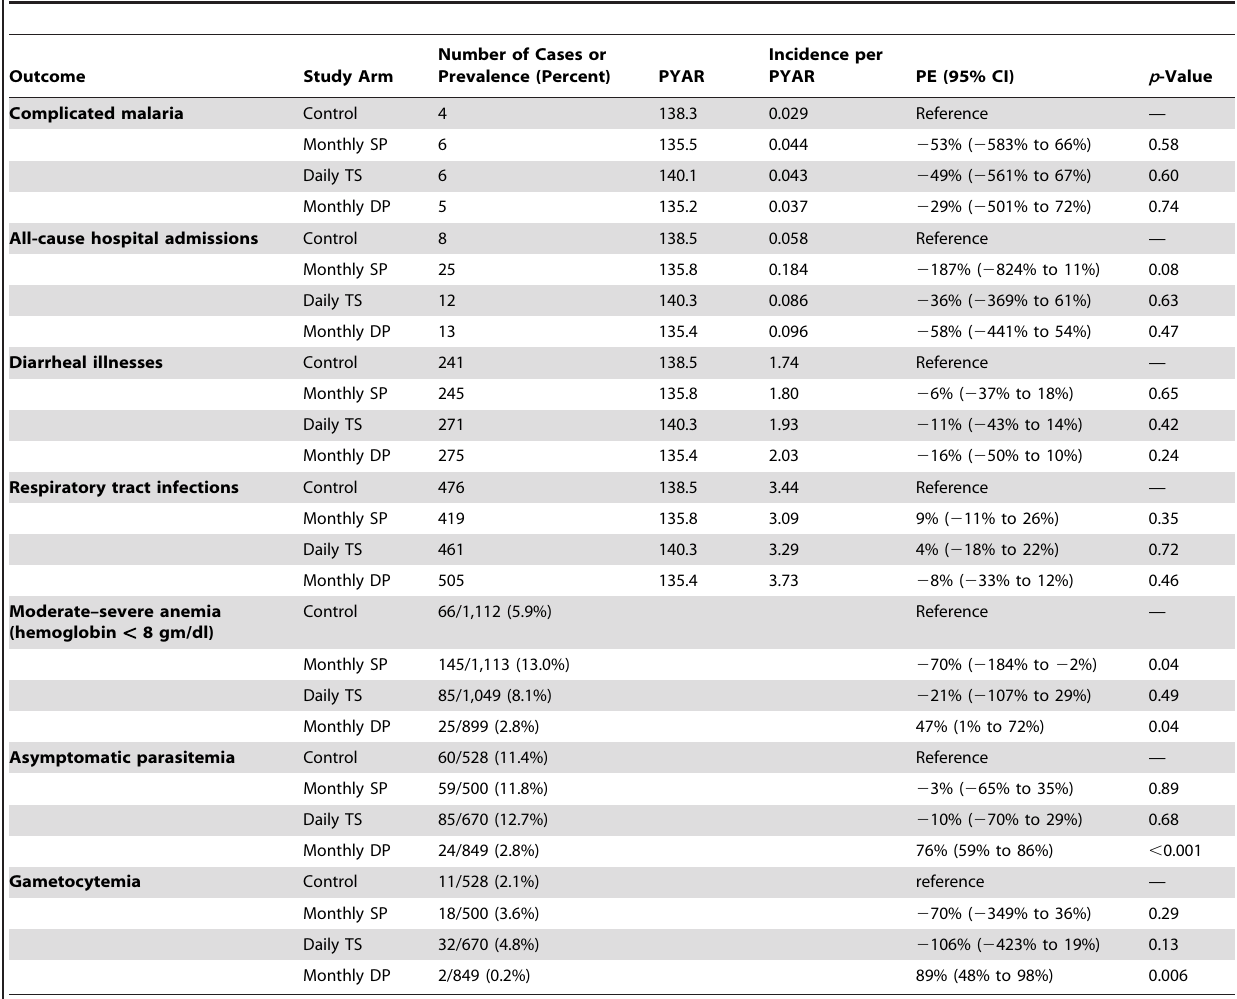
Table 4. Comparative effectiveness against secondary